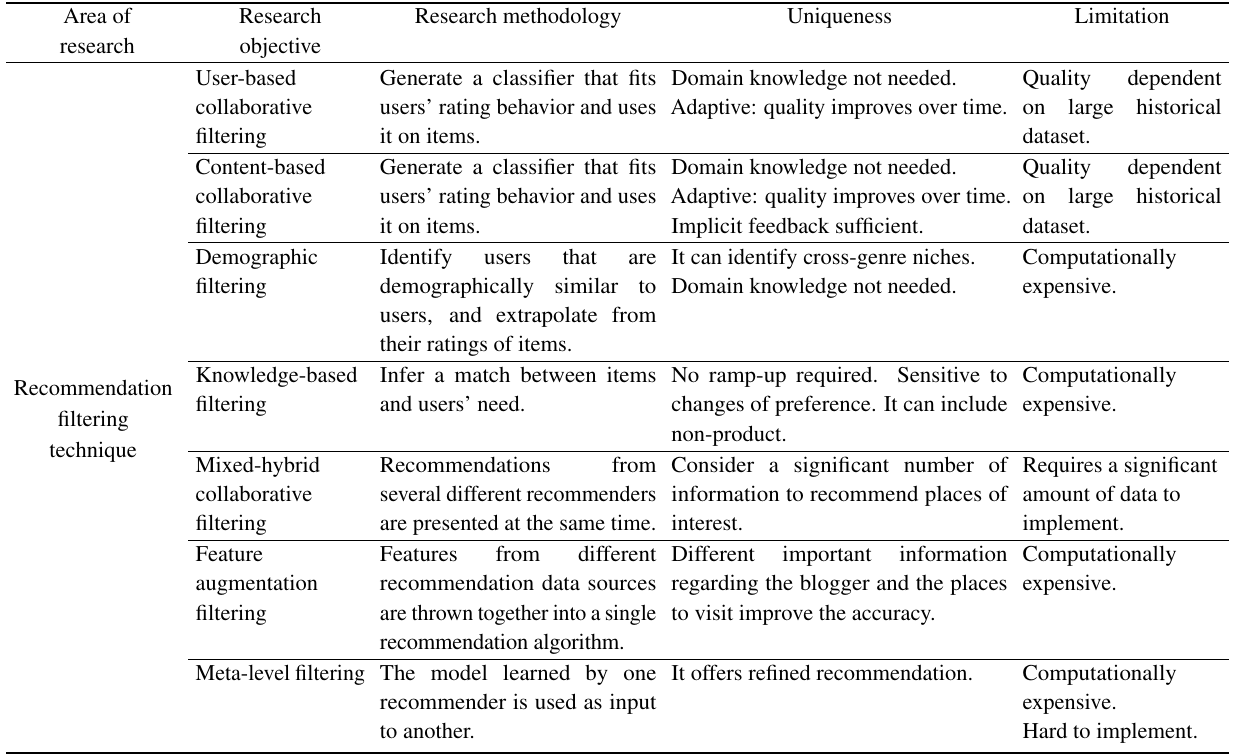
Table 2 Comparison for different recommendation filtering